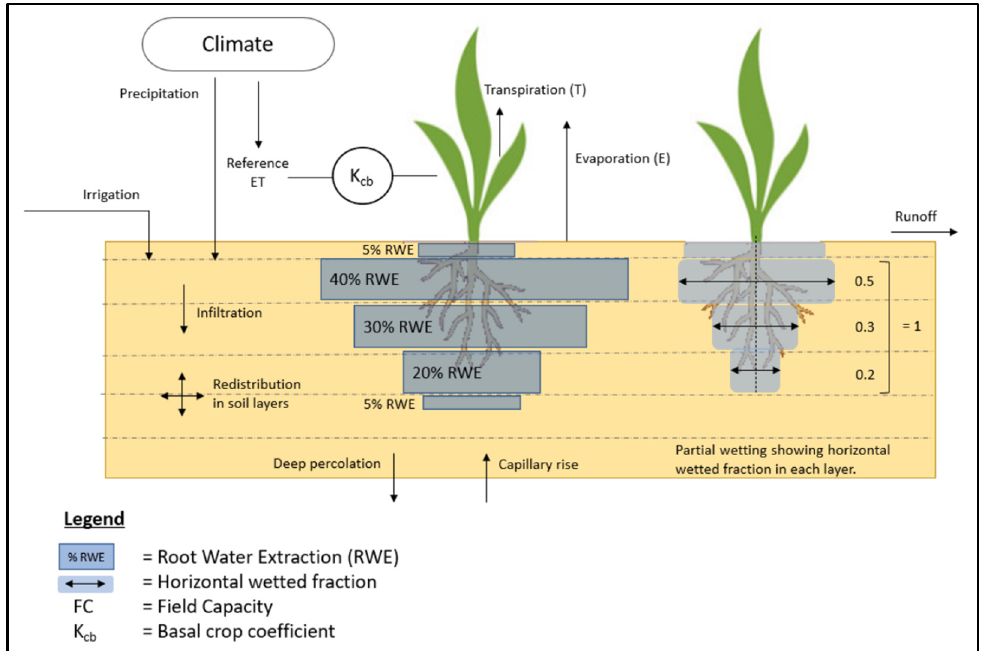
Figure 1. Schematic diagram of the WINDS irrigation model.